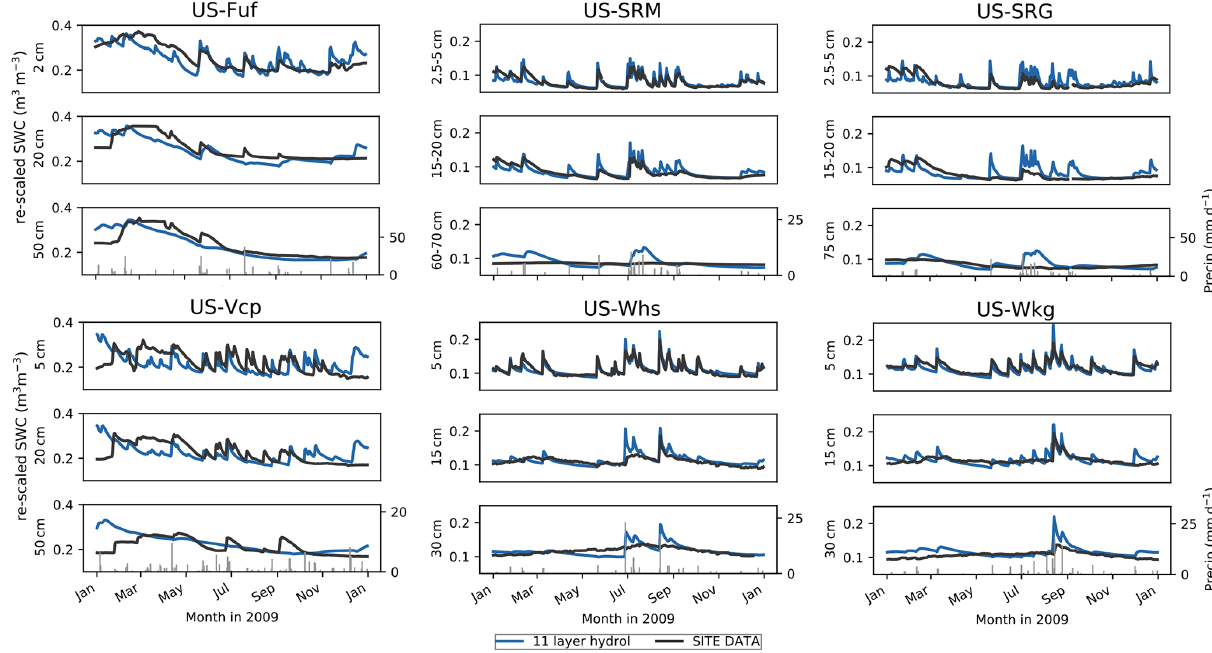
Figure 4. Daily simulated volumetric soil water content (SWC – m 3 m − 3 ) in 2009 (re-scaled via linear CDF matching) compared to obser- vations at each site for three depths (upper, middle, lower) in the soil profile. The soil depths and their corresponding model layers are given in Table 3. Precipitation is shown in the grey lines in the bottom panel for each